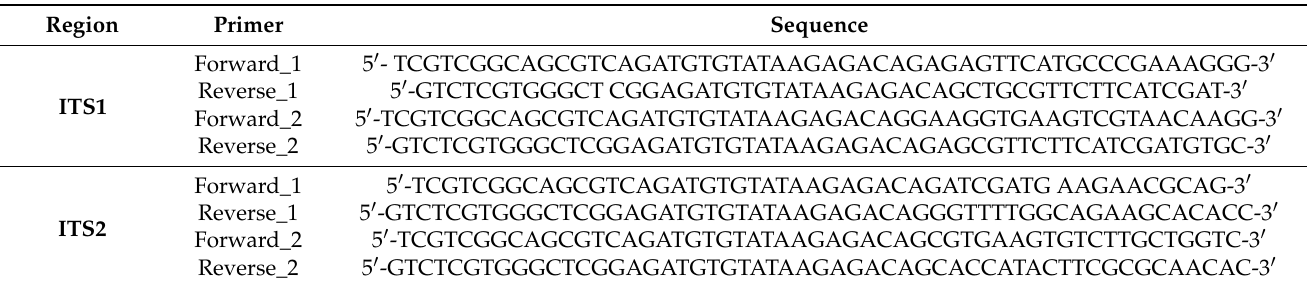
Table 2. Sequences of the primer sets (containing the Illumina overhang adapters) that were used for the amplification of the regions ITS1 and